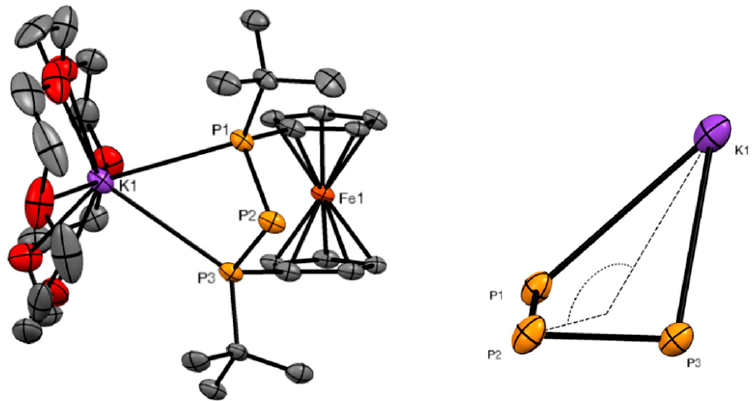
Figure 4. ORTEP plot of 4 · [18]-crown-6 (Scheme 3; ( left )) and expansion of the folded P 3 K ring ( right ). Ellipsoids were drawn at the 30% probability level. Hydrogen atoms were omitted for clarity.